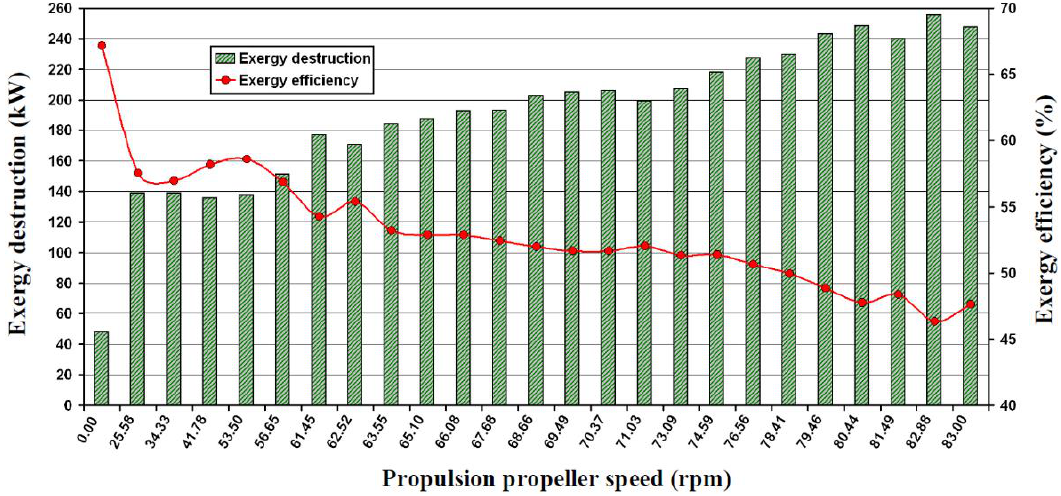
Figure 8. Exergy destruction and exergy efficiency of the steam air heater during various loads.